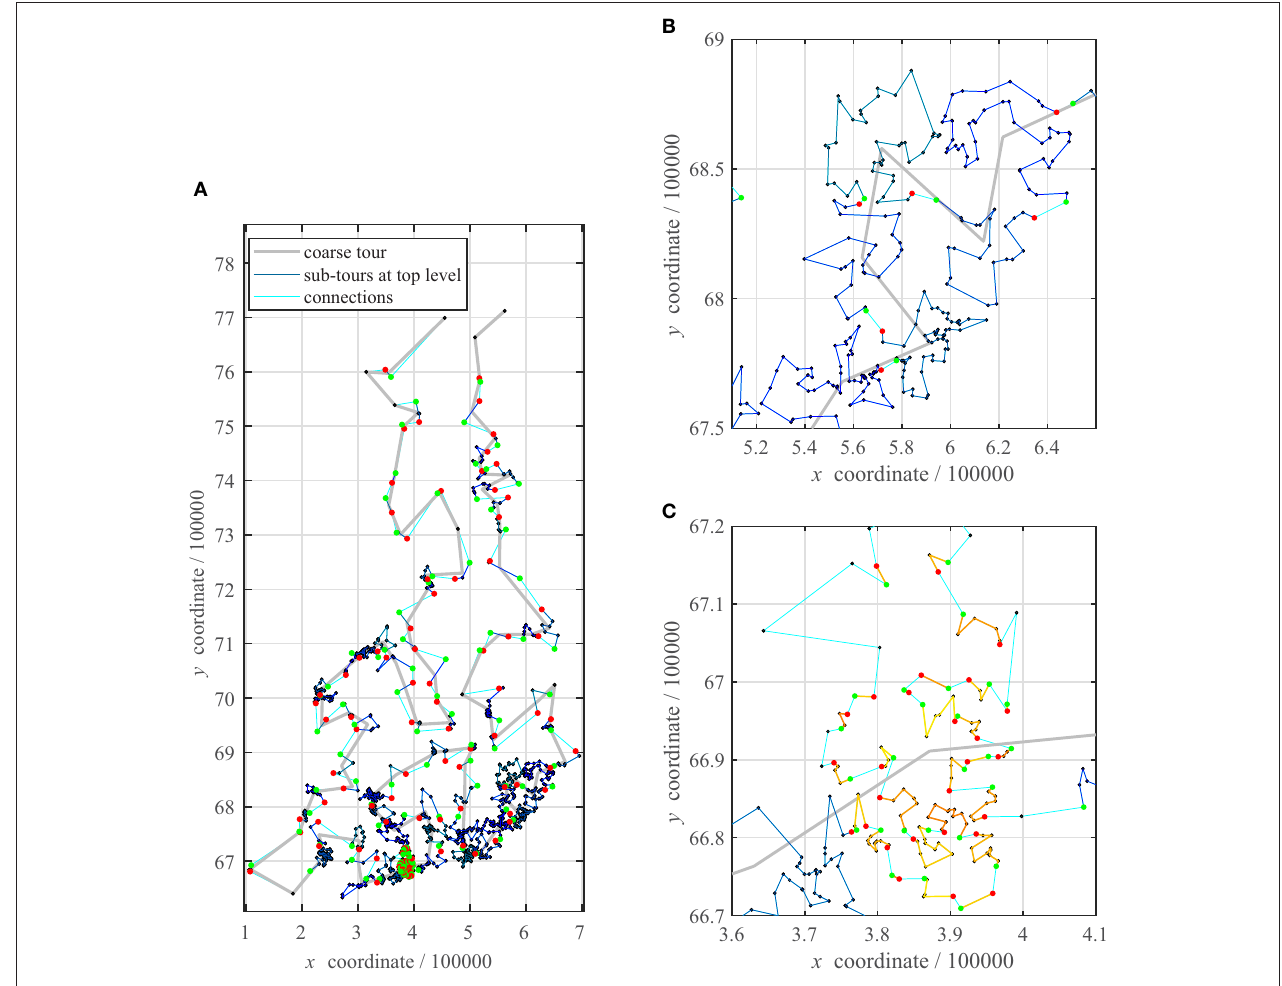
FIGURE 3 | Sub-tours: (A) map of all 1,437 points; (B) close-up of (A) : sub-tours on top level; (C) close-up of (A) : sub-tours on second level.